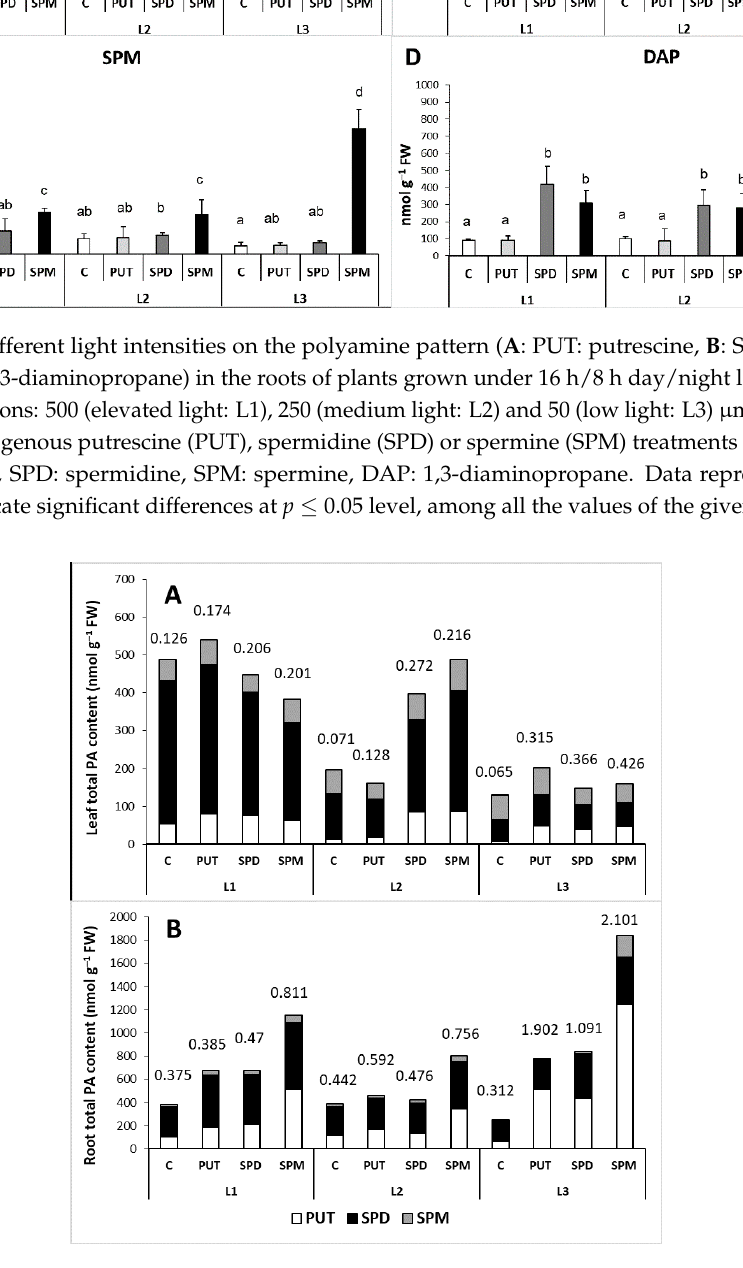
Figure 6. Effect of light intensity on the total polyamine (PA) content in the leaves ( A ) and roots ( B ) of plants grown under 16 h/8 h day/night light period with different light intensity conditions: 500 (elevated light: L1), 250 (medium light: L2) and 50 (low light: L3) μ mol m 2 s − 1 LED light after 7 days of 0.3 mM exogenous putrescine (PUT), spermidine (SPD) or spermine (SPM) treatments or without any treatment (C). Numbers indicate the ratio of PUT/(SPD + SPM).